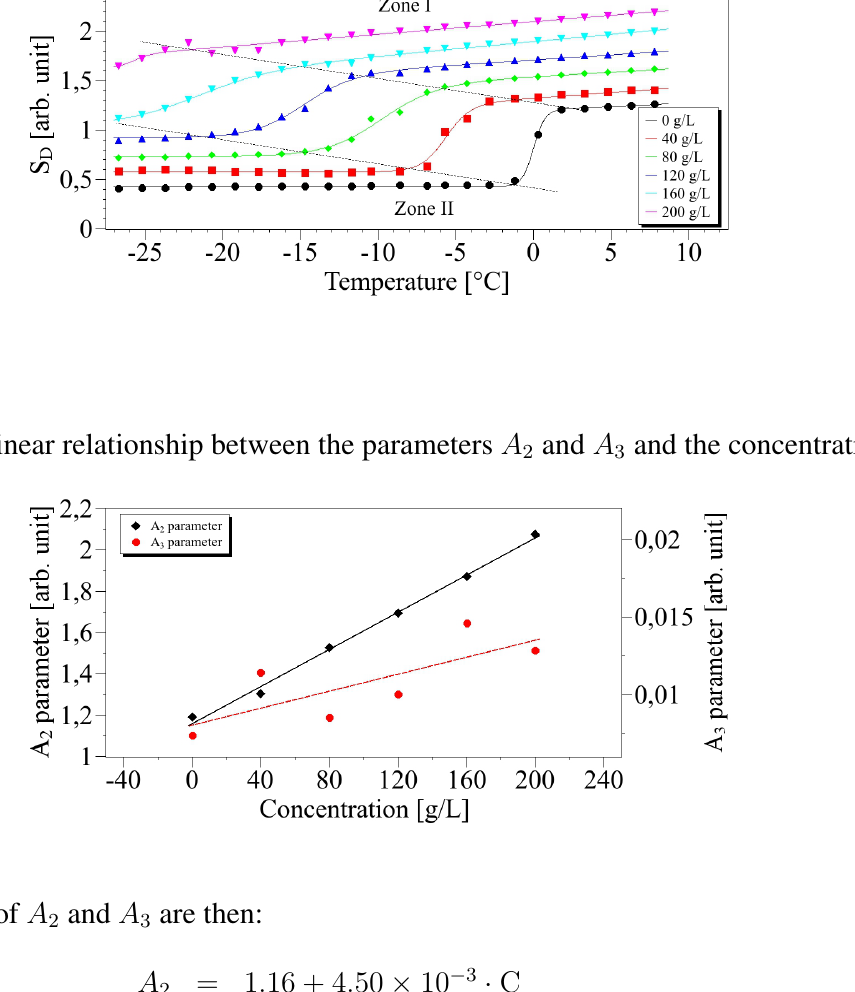
according to the temperature for several values of D